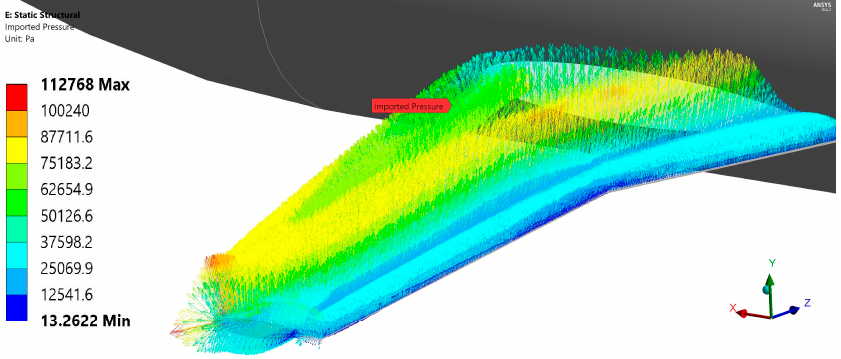
Figure 19. An example of spanwise air pressure distribution (Pascal) over DLR-F4 wing surface. Surface pressure field serves as the basic information for aerodynamic loads estimation.